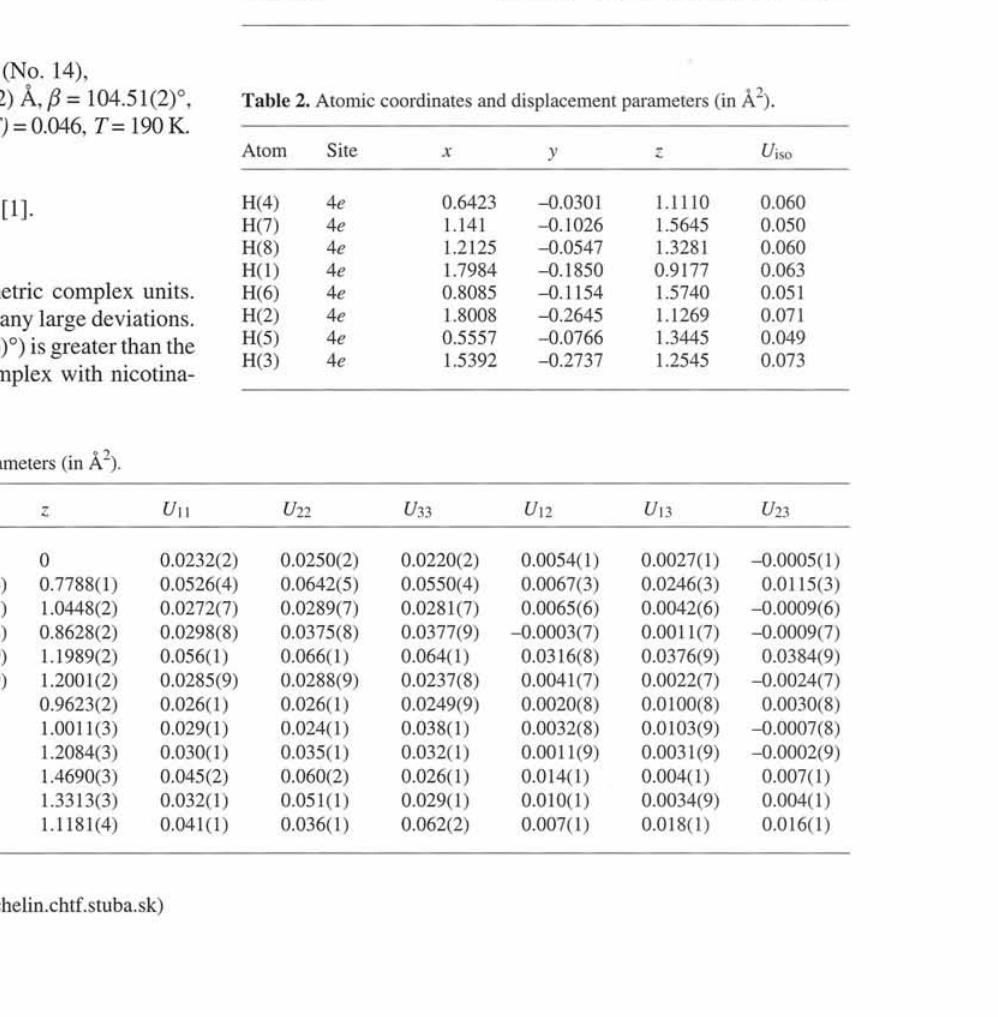
Table 2. Atomic coordinates and displacement parameters (in Á 2 ).